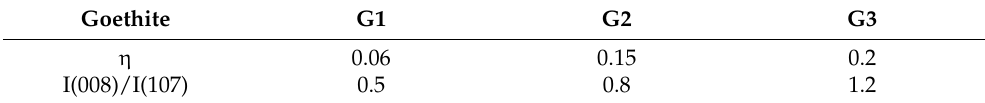
Table 2. Influence of the aspect ratio of the goethite on BaM particles stacking.